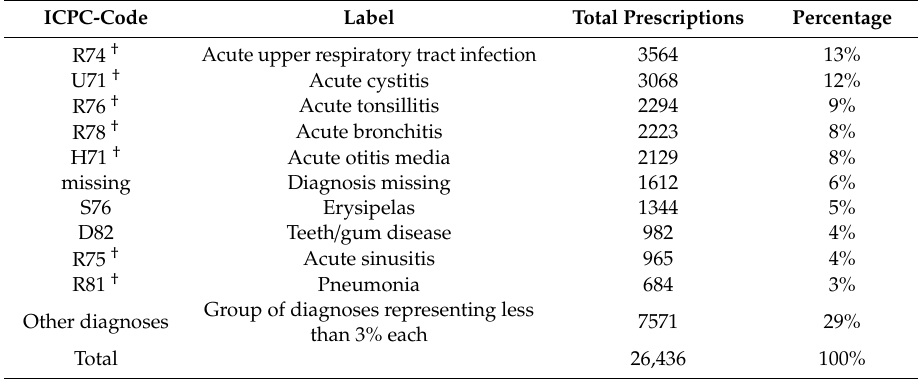
Table 4. Total antibiotic prescriptions and percentage linked to the diagnosis in a two-year time frame. (total patient contacts (excluding home visits) =